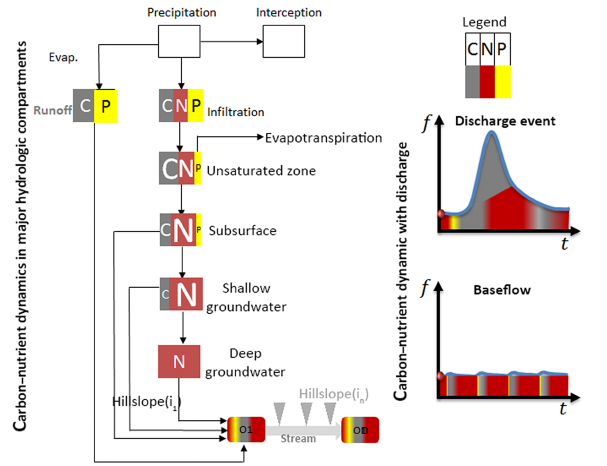
Figure 6. Conceptual model of carbon and nutrient dynamics in major hydrologic compartments during transient (discharge events) and steady-state (baseflow) discharge regimes. On the left side, we represent the relative abundance of carbon, nitrogen, and phos- phate during vertical transport through soil, unsaturated zone, and groundwater. Arrows represent flow paths, which can either descend through the soil column or lead directly to the stream (represented at the bottom of the figure), which experiences fluctuations in water chemistry based on the relative contribution of these flow paths from multiple hillslopes. On the right side of the figure, schematic repre- sentations of stream chemistry during stormflow and baseflow are shown. The colors represent carbon, nitrogen, and phosphorus con- centrations, which vary depending on hydrologic conditions. See Sect. 4.2 in the “Discussion” section for more detailed interpreta-